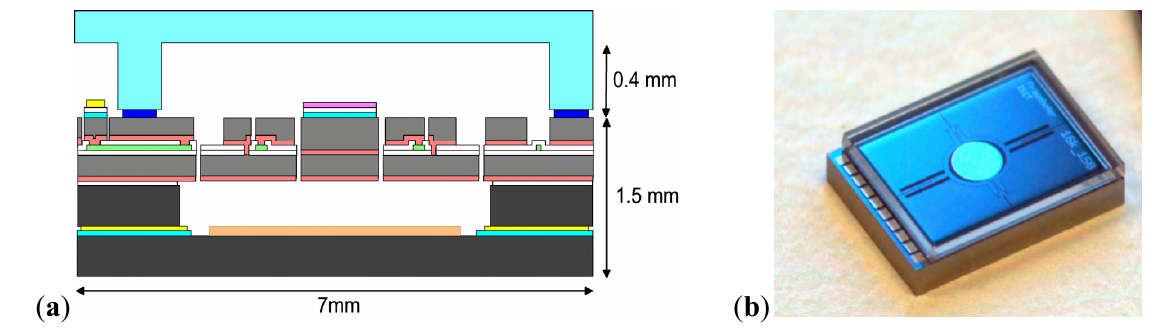
Figure 6. ( a ) Schematic cross section of a wafer level vacuum packaged MEMS mirror with integrated thin film getter; ( b ) Vacuum packaged biaxial MEMS